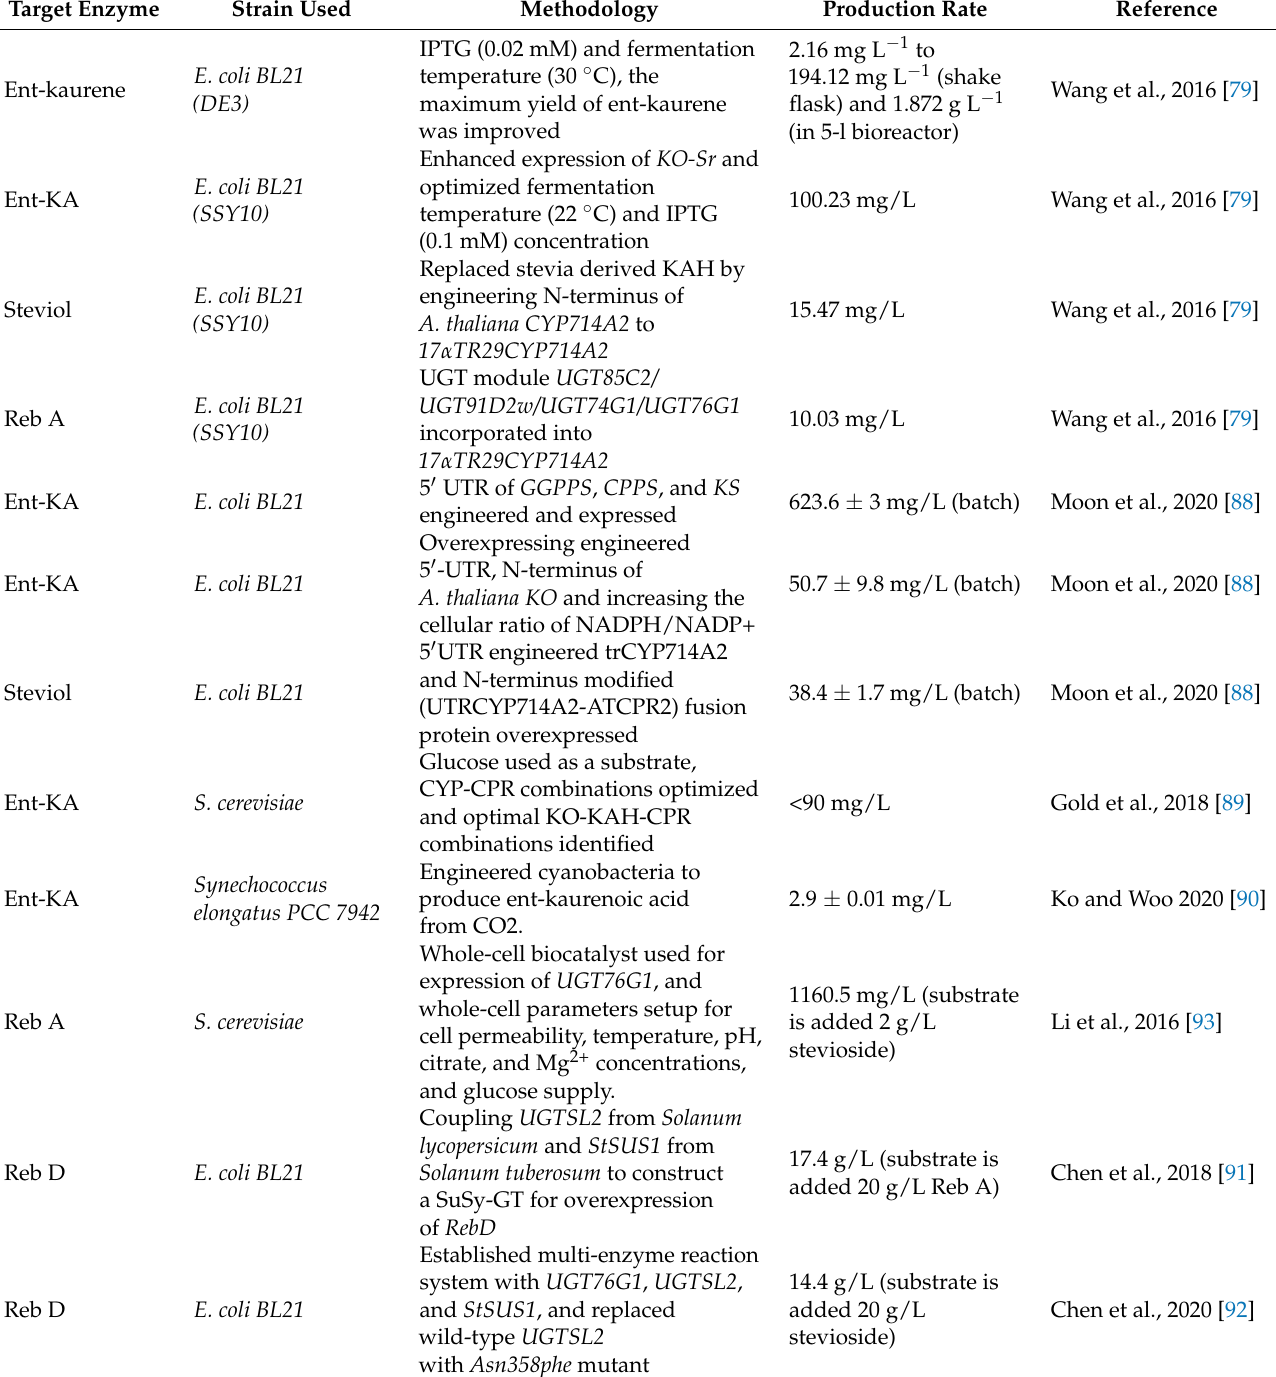
Table 4. Overview of the summarized table depicting the developments made in the metabolic engineering for the production of steviol